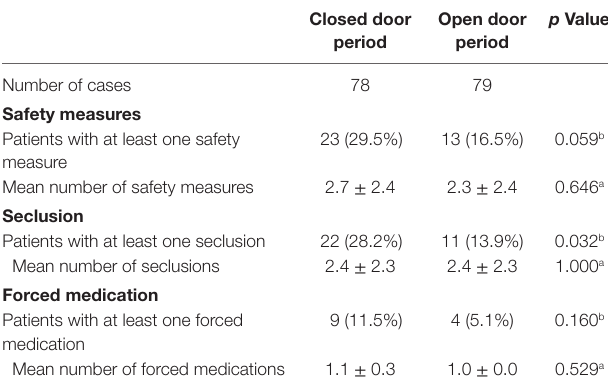
TaBle 3 | Safety measures before and after the introduction of predominantly open doors on the